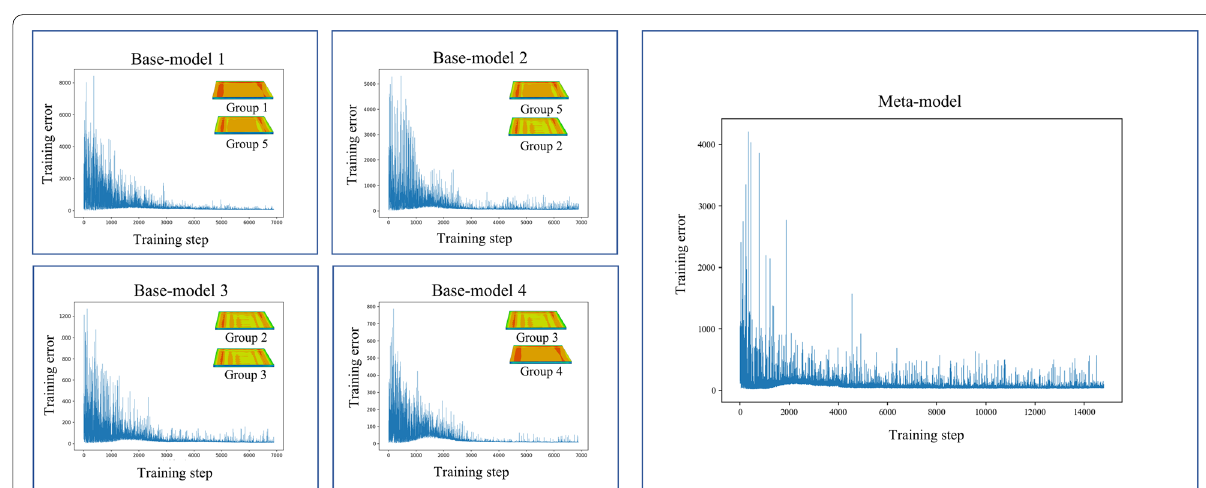
Fig. 11 Convergence curves in training process of Part